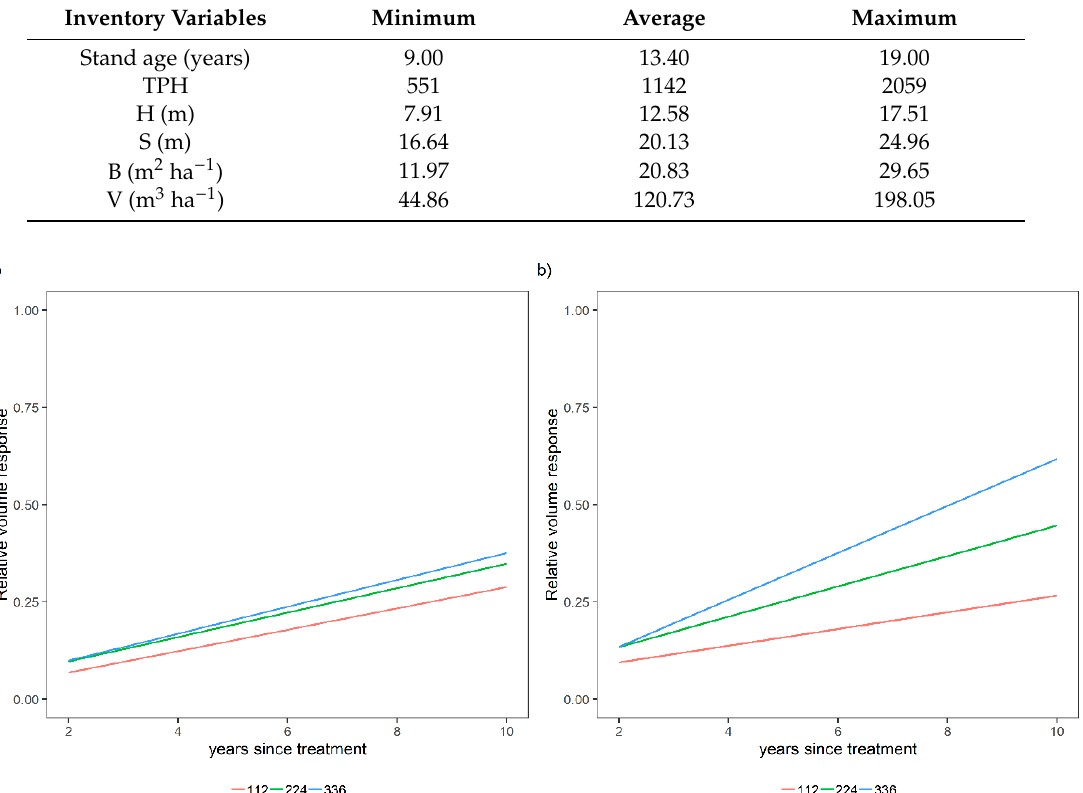
Figure 2. Relative volume response for the N treatments (112, 224, and 336 kg ha − 1 elemental N) compared to the control treatment over time for treatments where P was not applied ( a ) and where 28 kg ha − 1 of elemental P was applied ( b ). These data represent average volume response in SEUS.